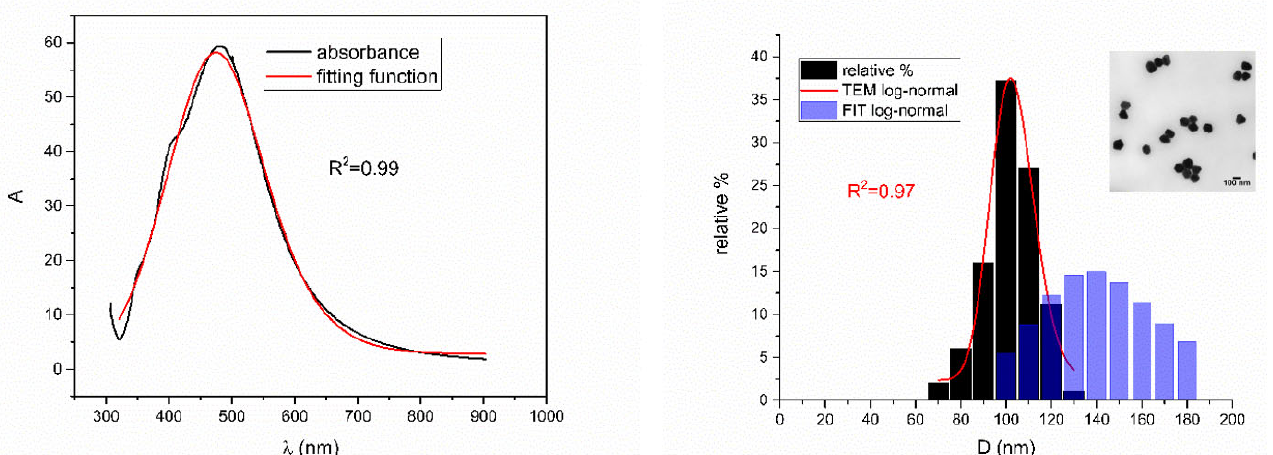
size distributions are shown on the ( right ). An additional TEM image is also shown.